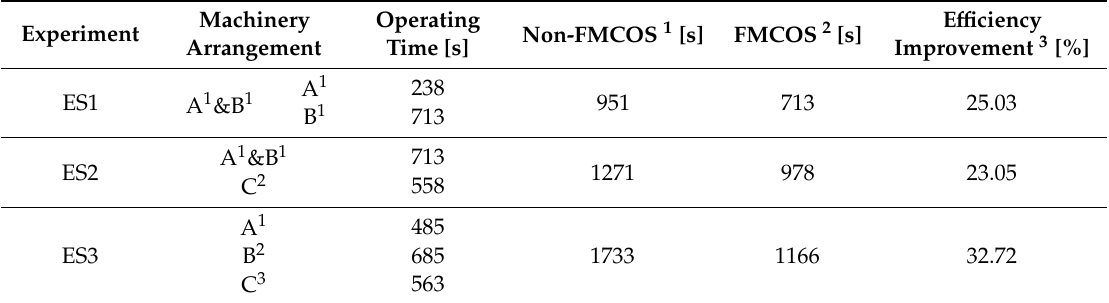
Table 3. Comparison between Non-FMCOS and FMCOS data in regard to efficiency improvement for ES1, ES2, and ES3.